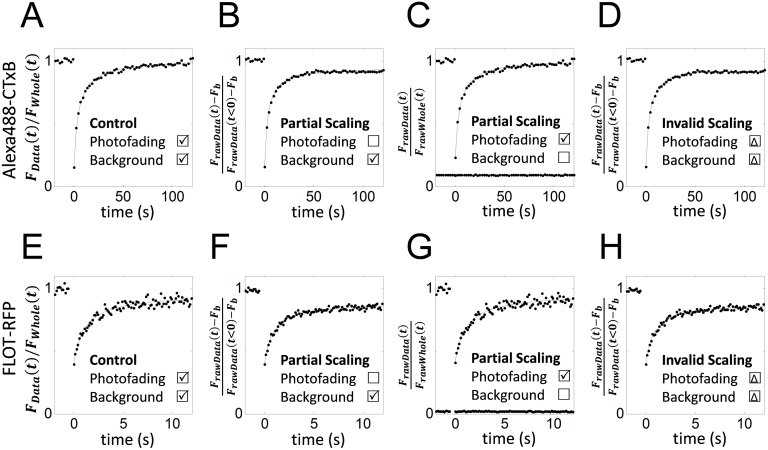
Errors caused by incorrect sequence of scaling or by applying partial scaling corrections.FRAP analysis was performed on Alexa488-CTxB FRAP data (A–D) or FLOT-RFP FRAP data (E–H) using different scaling scenarios. (A,E) As a positive control, FRAP data corrected for both background fluorescence and photofading were analyzed using f
NDaMf(t) (Eq 37) in the correct order. (B,F) Background-corrected FRAP data were analyzed by f
NDaMf(t) (Eq 37), ignoring the contribution of photofading. (C,G) Photofading-corrected FRAP data, F
Data(t)/F
Whole(t) were analyzed by f
NDaMf(t) (Eq 37), ignoring any background correction. Lower lines show background fluorescence, F
b. (D,H) Background corrected FRAP data were analyzed using a photofading and mobile fraction corrected FRAP equation obtained by using an incorrect scaling order (Eq 44). Dots (•) show the mean FRAP data averaged over one set of experiments (n = 12 and 13 for FLOT-RFP and Alexa488-CTxB, respectively) and solid lines show the best fitting curve.